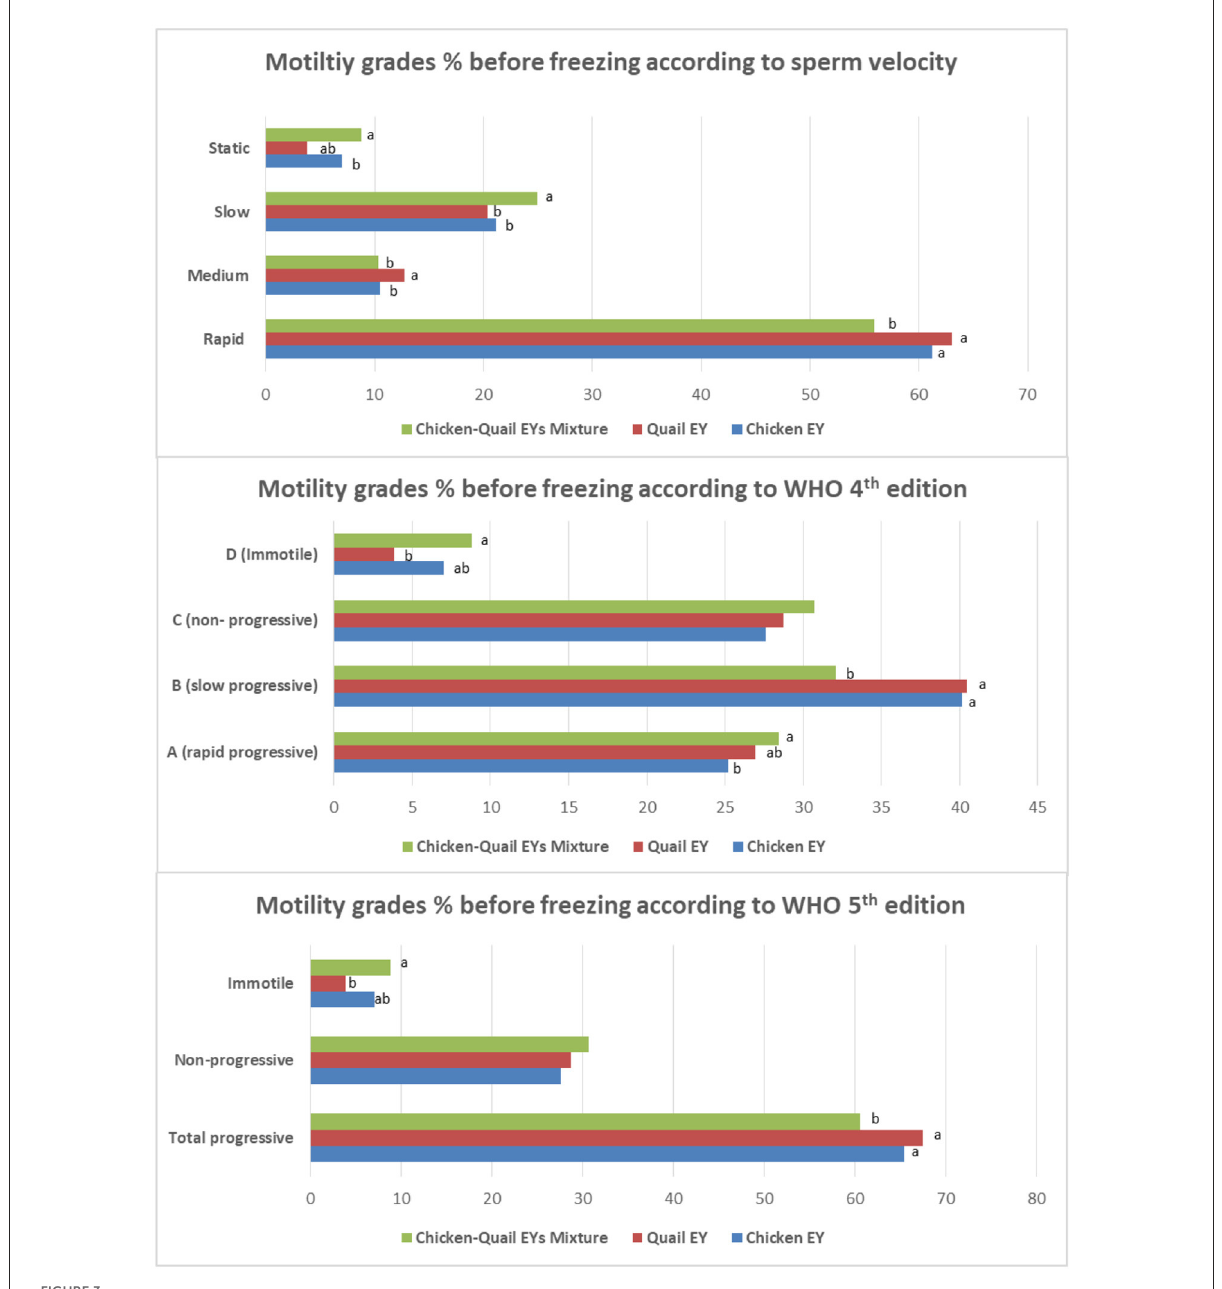
FIGURE3 Effects of adding and combining egg yolks (EY) of chicken and/or quail to the Tris glycerol extender on motility grades of ram sperm before freezing. a,b,c, different letters indicate significant differences among the different egg yolks for each evaluated parameter; Progressive motility, Percentage of sperm presenting movement with a STR index ≥ 80% within the sample; Statics, VCL < 10 µ m/s; Slow, 10 < VCL < 45 µ m/s; Medium, 45 < VCL < 75 µ m/s; Rapid, VCL > 75 µ m/s. In WHO 4th edition, the more details of progressive motility were added including slow or rapid progressive. While, in WHO 5th edition, the total progressive motility was presented as a one category regardless sperm velocity.